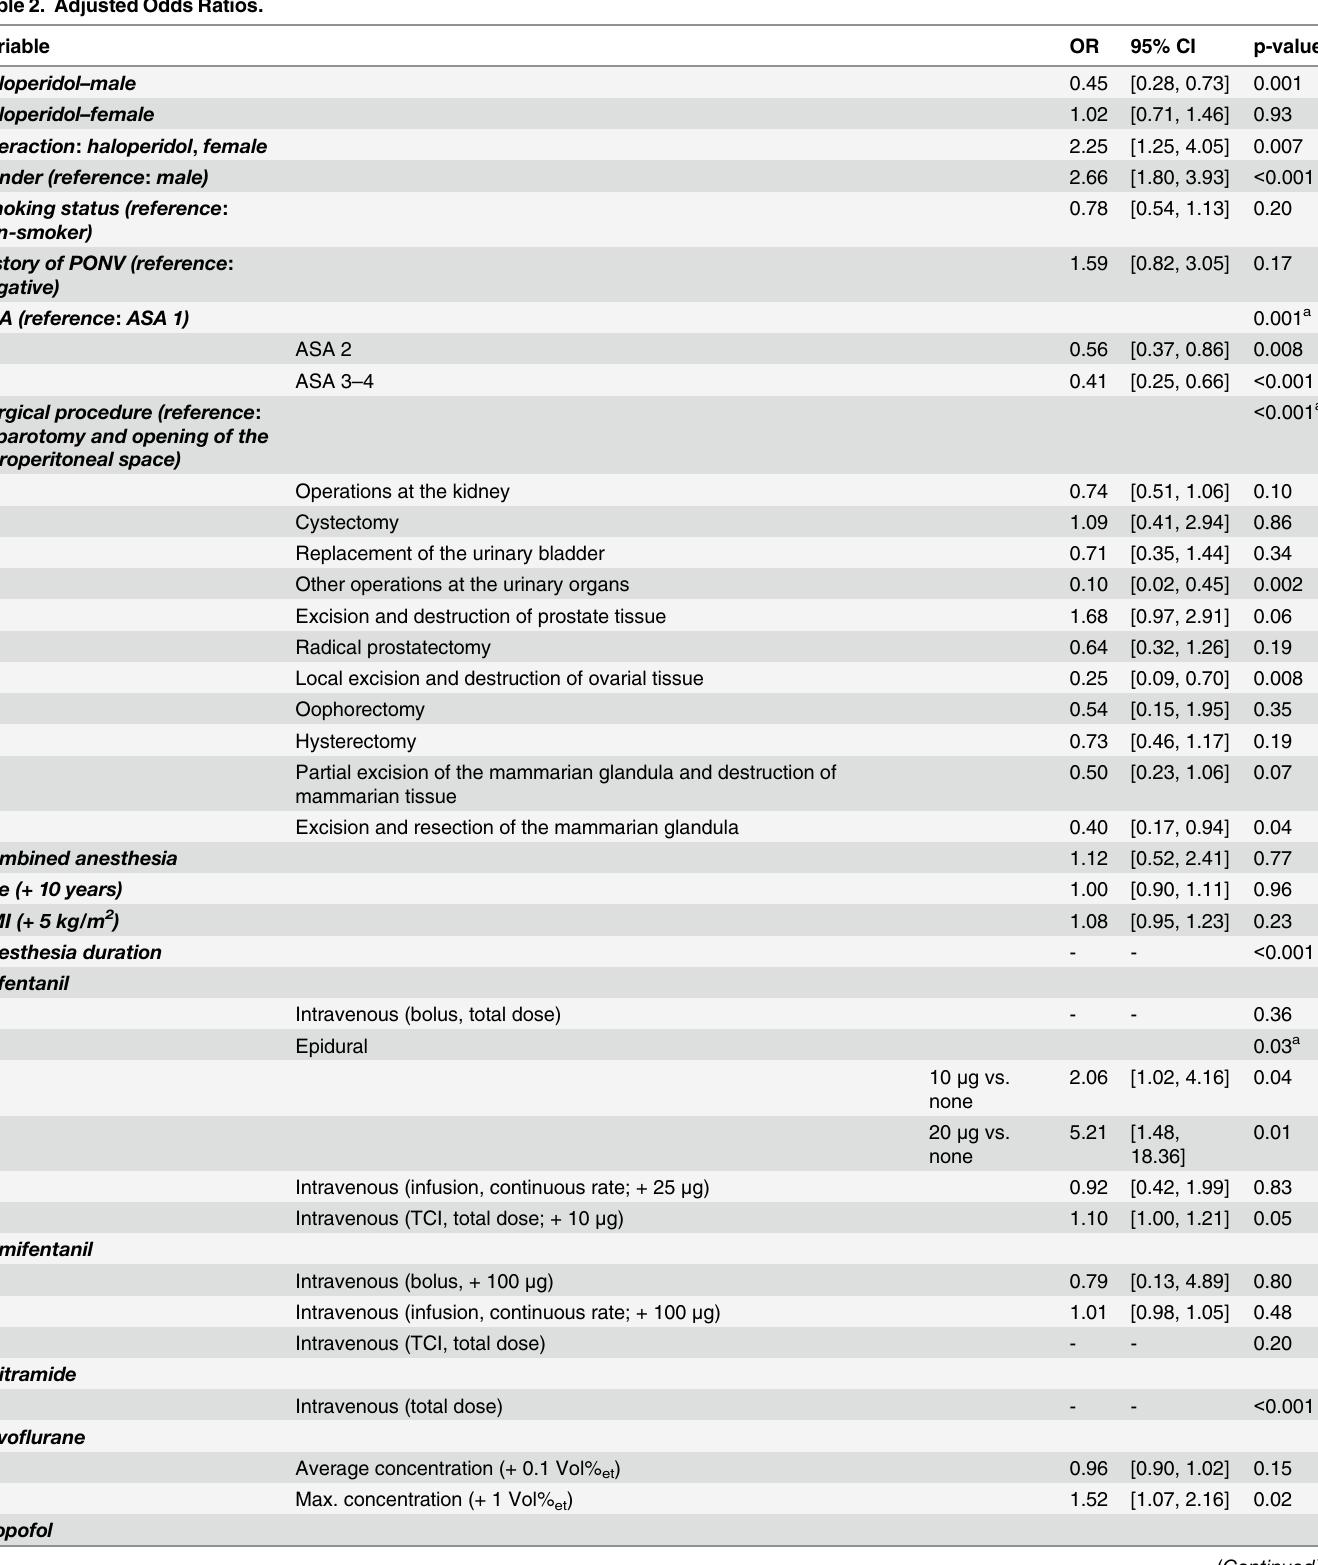
Table 2. Adjusted Odds